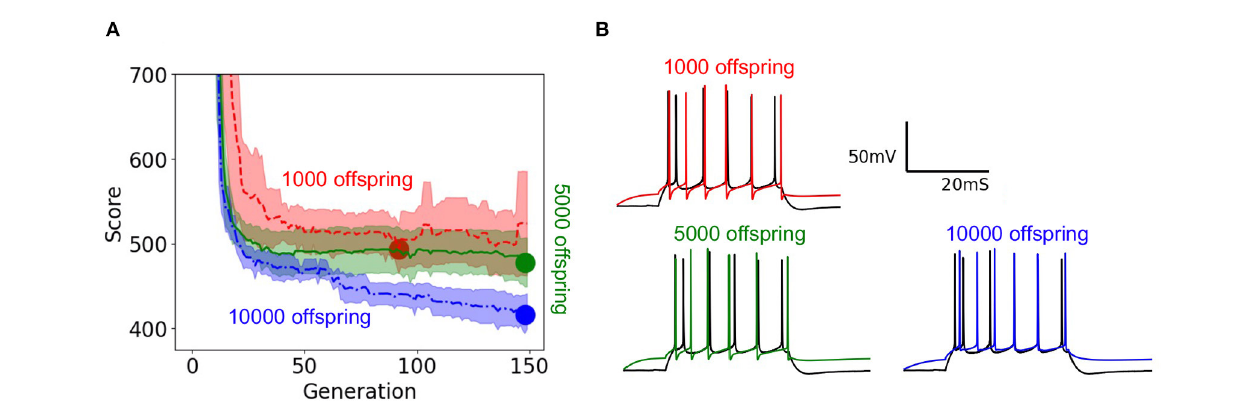
FIGURE 7 | EA score and model fit both improve with larger population size: (A) Objective function optimization trajectory in EA with varying population sizes. Scores start around 2,500 but the y-axis is constrained to clearly show results. Lower scores indicate a closer fit to experimental data. The minima of the objective function are denoted by large circles and the lower the minima the more the best simulated response resembles the experimentally recorded waveform. Confidence intervals are computed using 10 random initializations. Panel (B) illustrates the neuron model responses corresponding to varying population